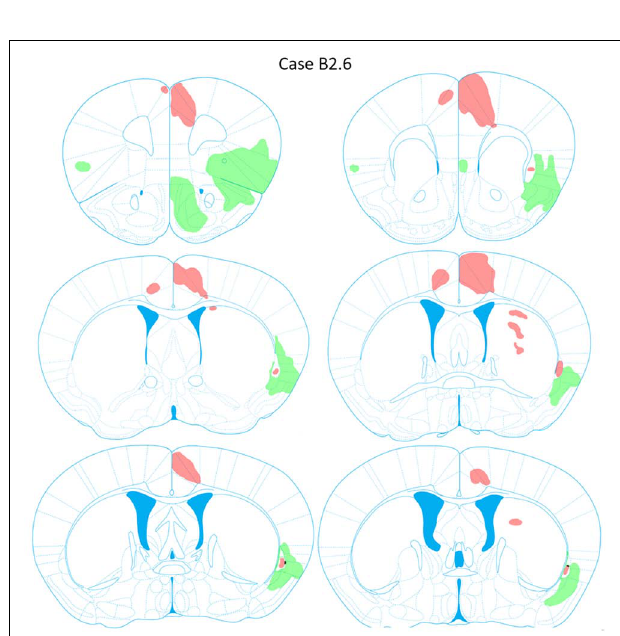
FIGURE 10 | Chartings of anterograde labeling following viral injections into the aINS (green) and ACC (red) (case B2.6). Overlap in expression is colored in